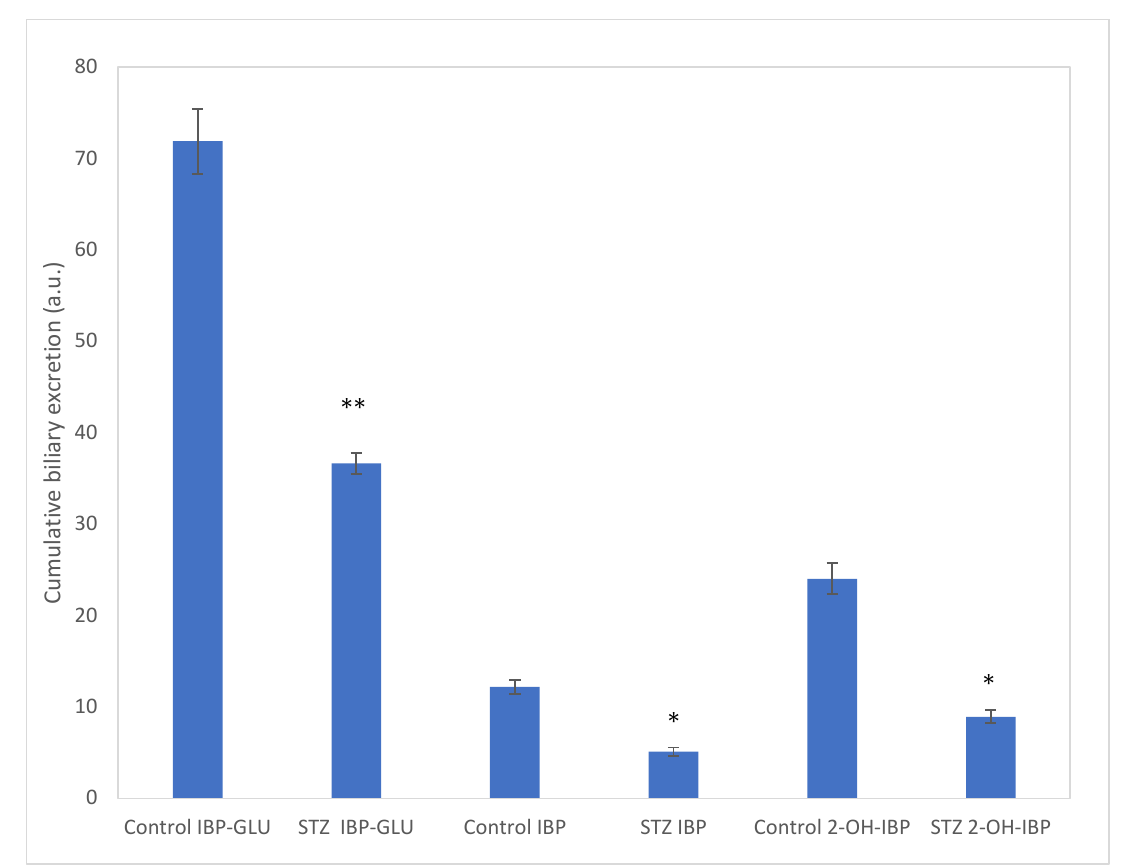
Figure 4 . Cumulative biliary excretion (HPLC-UV (Method II) based integration) of IBP ( 1 ), IBP-GLU ( 6 ), and 2-OH-IBP ( 3 ) after the 90-min luminal perfusion of 250 μ M IBP in control and hyperglycemic (STZ-treated) rats. Each value represents the average of five independent experiments ± standard error. Significant difference from the control value: * p < 0.05, ** p < 0.01.